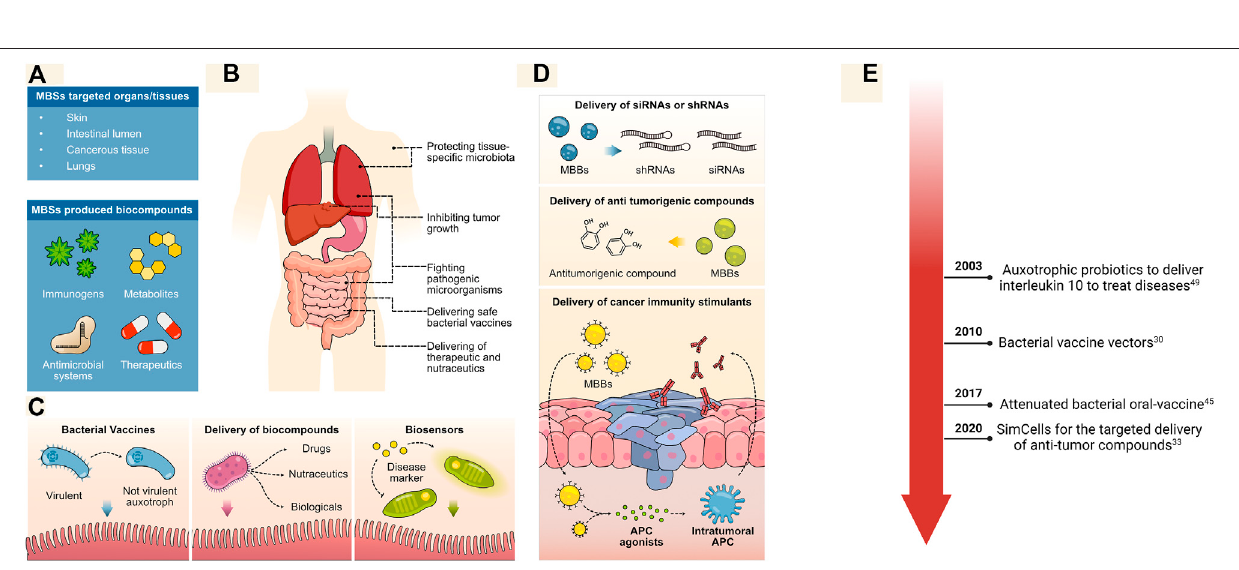
andtotestforthepresenceofdiseasesusingavailablebiomarkers(right-mostpanel). (D) StrategiesusedtotreattumorigenictissueswithMBSs,includingthedeliveryof RNAs,drugs,andimmunestimulants.MBBsareusedfortargeteddeliveryofshRNAsandsiRNAstotumorsasameantoknockdowndrug-resistancegenes(top panel);MBBscanalsobeusedasadirectbiomanufacturingmachineryforsynthesisofantitumorigeniccompounds(middlepanel)orevenforthedeliveryofagoniststhat will induce the development of an immunity response against the tumor (lower panel). (E) Timeline for major medical